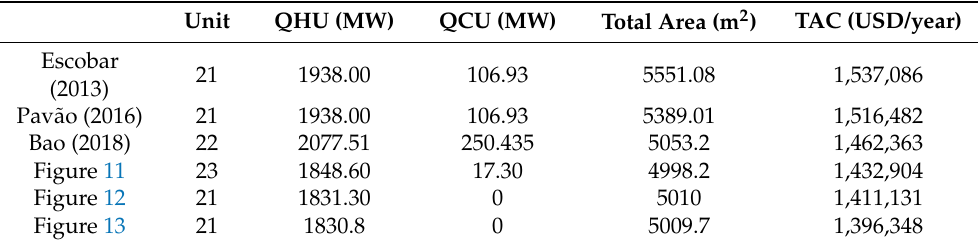
Figure 11. Result obtained through the original RWCE. Table 3. Comparison of the optimized results for Case